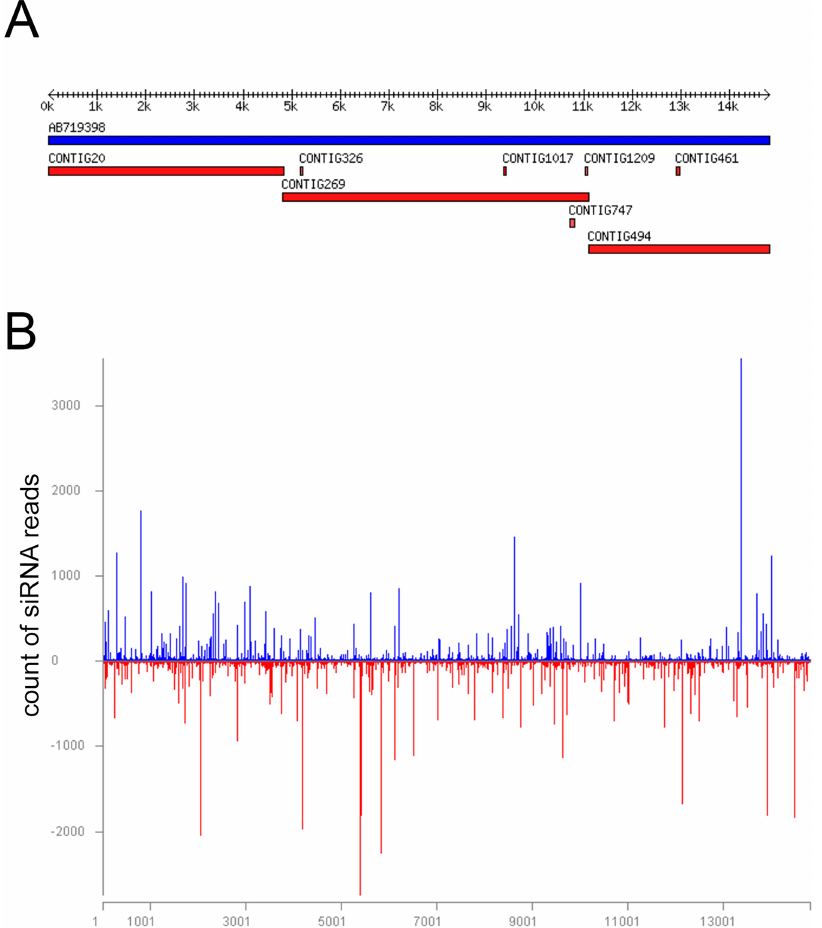
Fig 1. Identification of PvEV-2 in the sample pool HXH8 from the Southern Highland zone of Tanzania based on small-RNA deep sequencing. (a), Viral contigs (red bars) mapped to the sequenceof PvEV- 2-Okada (AB719398) [25] using VirusDetect [51]. Each nucleotide in the contigs was covered by siRNA reads at least 5 times. (b) The 21- to 24-nt reads mappedto the sequenceof PvEV-2. The x axis and the scale below the figure depict the viral genomeand nucleotide positions,respectively.The y axis indicates the number of siRNA reads derived from the coding strand (blue bars above the x axis) and complementary strand (red bars belowthe x